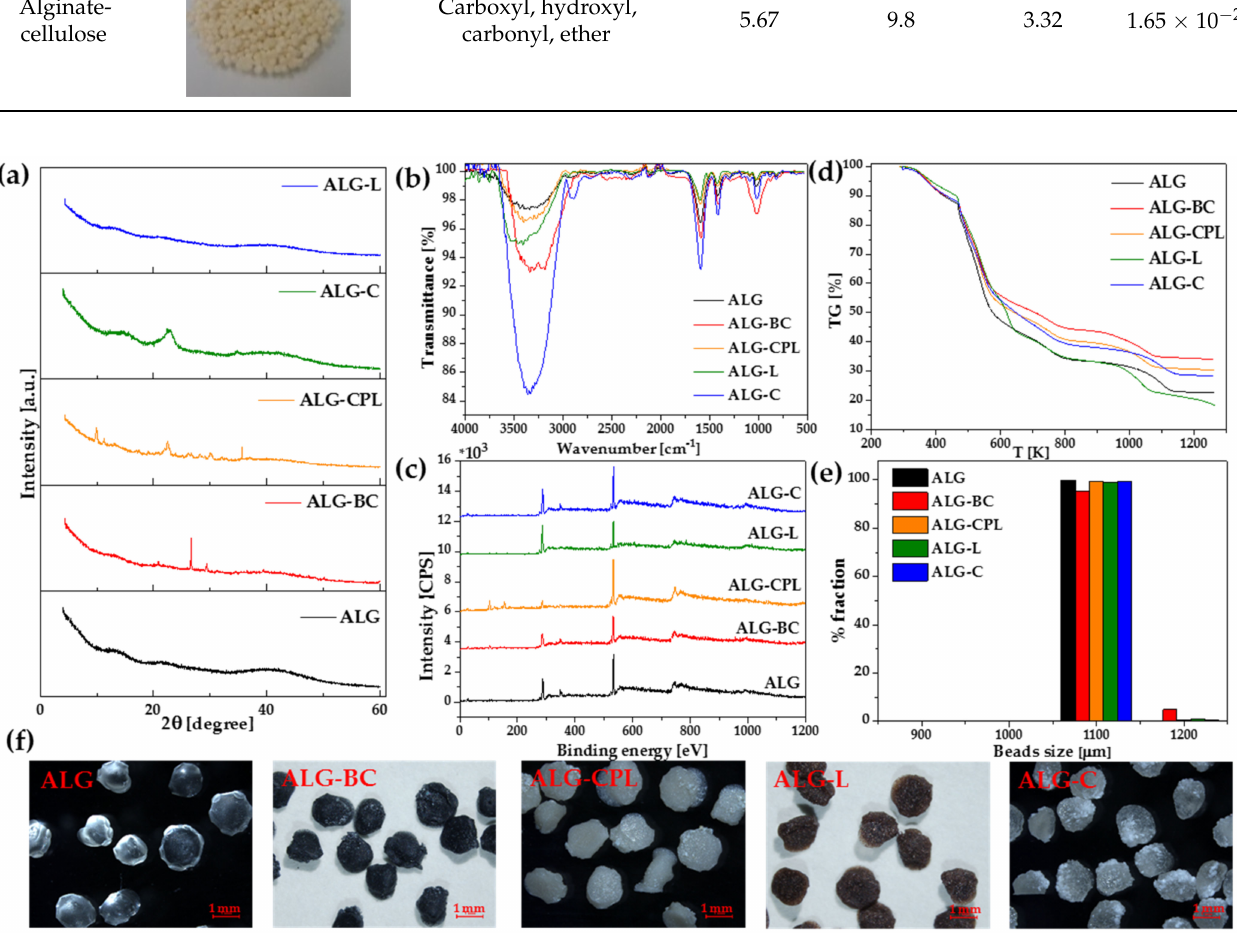
Figure 4. Physicochemical analyses of alginate-based adsorbents. ( a ) XRD pattern, ( b ) ATR/FT-IR spectra, ( c ) XPS spectra, ( d ) TG curves, ( e ) gradation tests, and ( f ) OM images (the scale bar denotes 1 mm